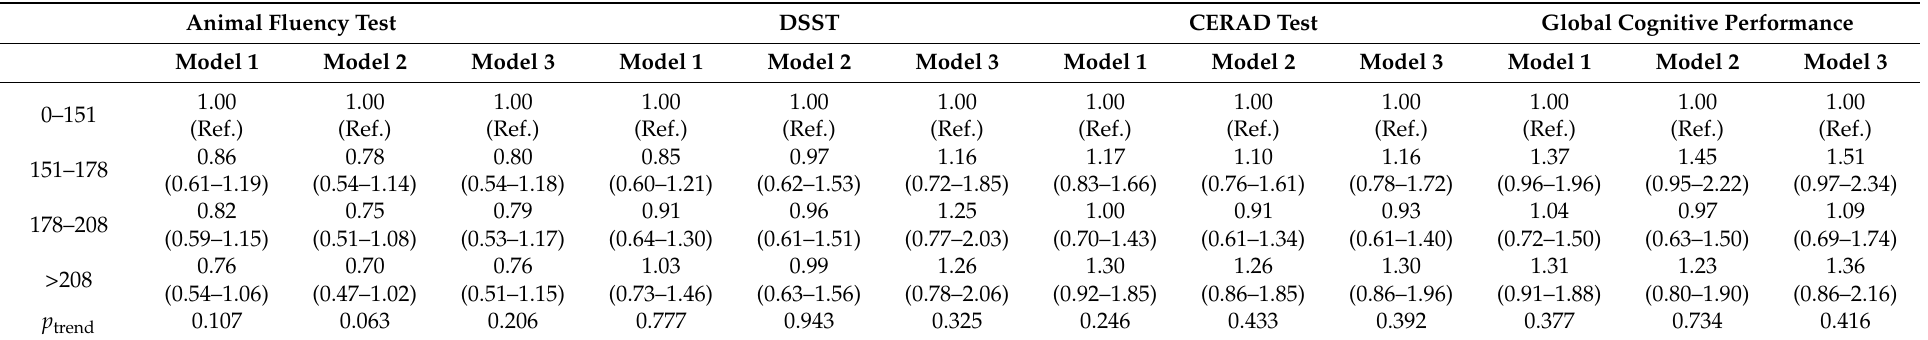
Table 5. Odds ratios (95% confidence intervals) for four dimensions of cognitive performance across quartiles of total cholesterol among male participants, NHANES